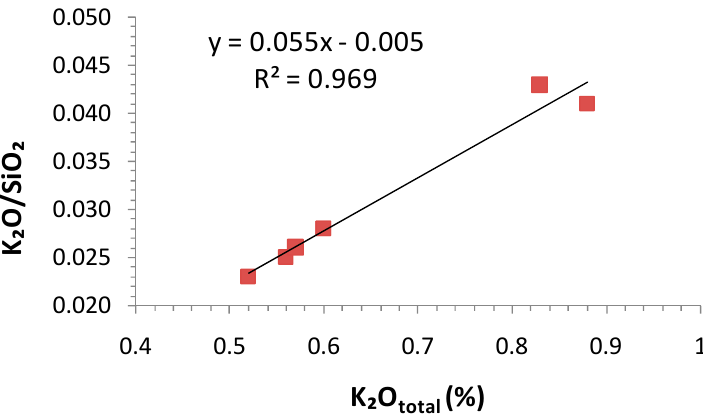
Figure 6. Comparison between total K 2 O and the K 2 O/SiO 2 ratio.